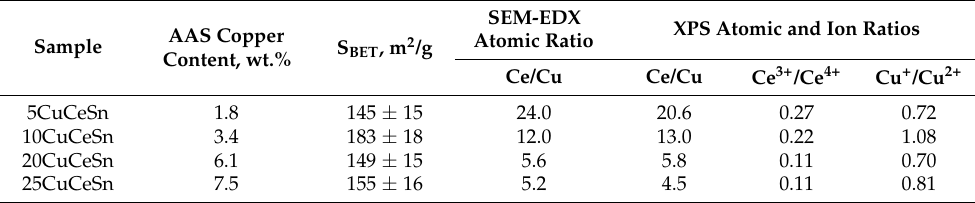
Table 2. Textural properties and chemical compositions of one-pot synthesized CuCeSn catalysts with different Cu contents. AAS Copper Sample Content,